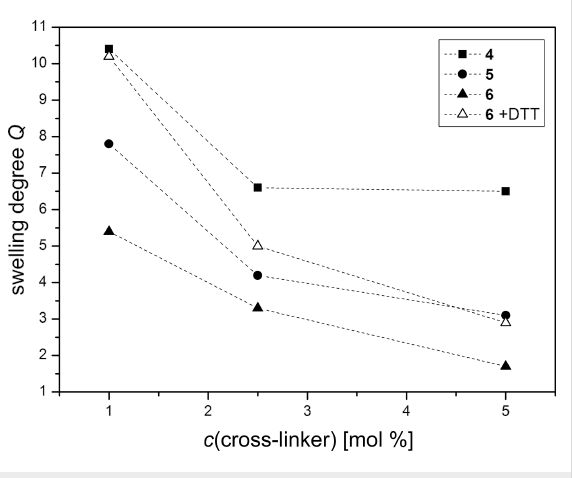
Figure 6: Swelling degree Q of polymer discs 4–6 as a function of the amount and type of containing cross-linker.